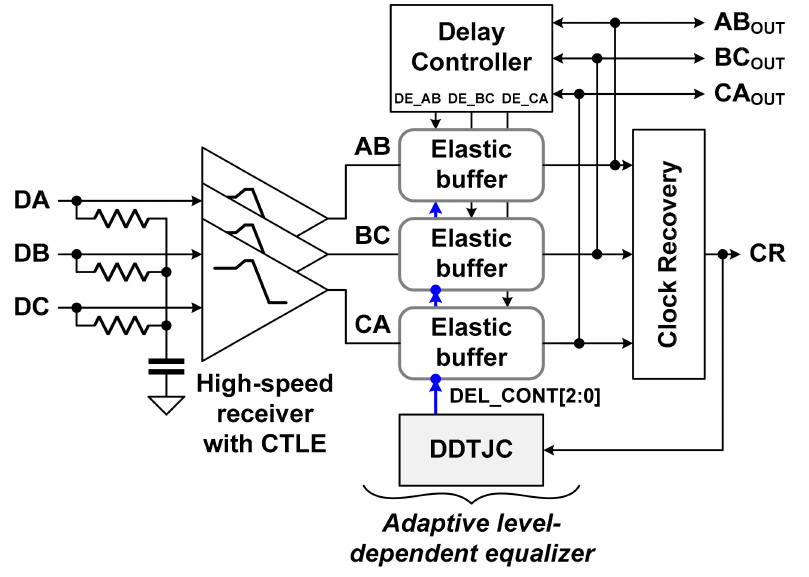
Figure 8. Block diagram of MIPI C-PHY receiver with ALDE.